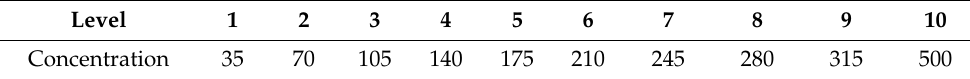
Table 1. Detailed haze concentration level